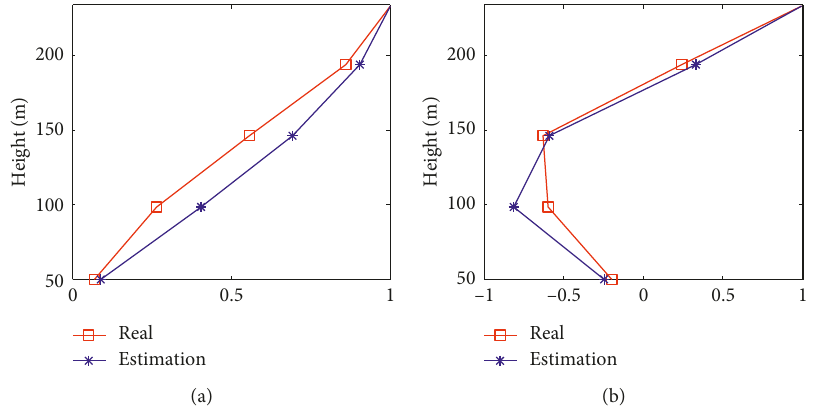
Figure 14: Comparison of the mode shape: (a) the first mode shape; (b) the second mode shape.